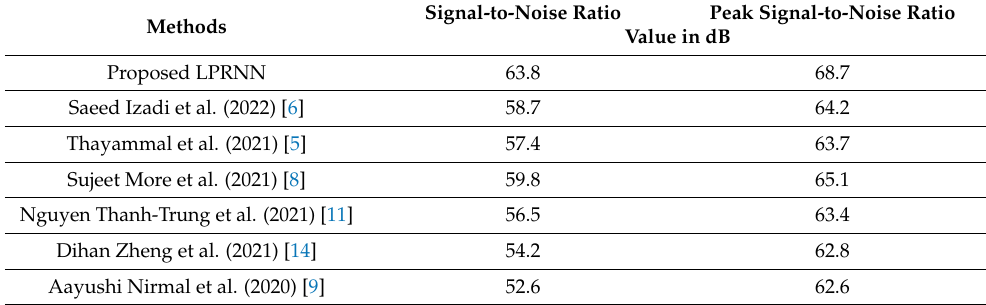
Table 2. Image noise removal state-of-art